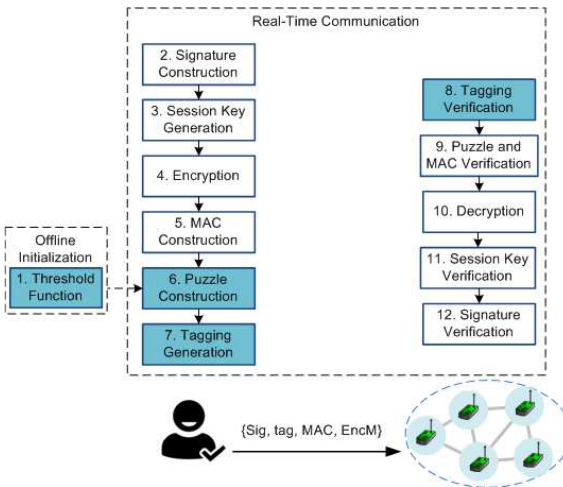
Figure 2. Dynamic Cipher Puzzle. The blue rectangles indicate the proposed